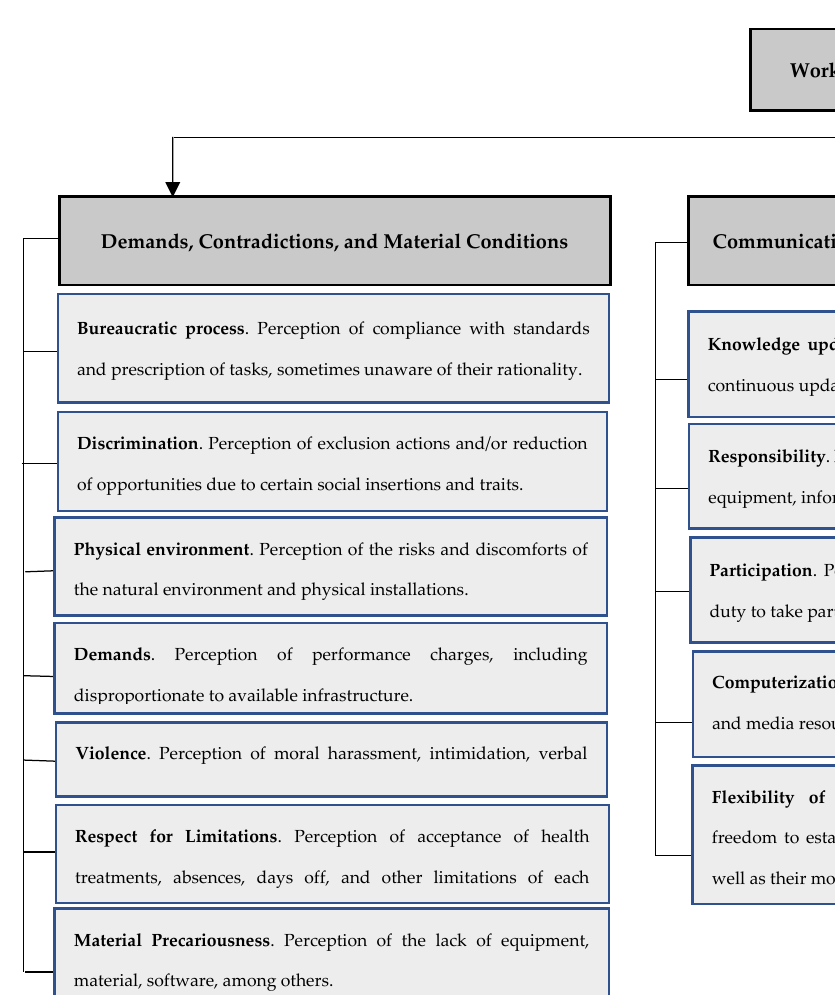
Figure 1. Factorial Structure of First and Second Order regarding the Work Conditions Questionnaire (WCQ). Legend: ( A ) = Factorial Structure of Second Order; ( B ) = Factorial Structure of First Order. Source: Borges, Barbosa, Ansoleaga, Barros, Heleno, and Rentería [51].